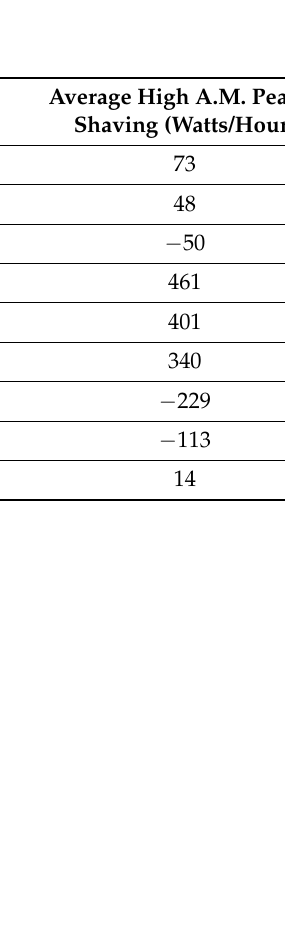
Figure 4. Example from targeted high and low a.m. peaker groups.